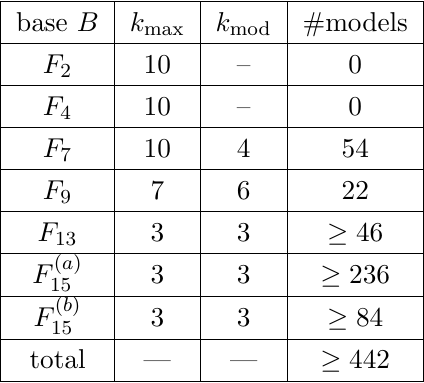
Table 3 . The number of phenomenologically interesting models found for each of the six base manifolds. The scan was carried out over all line bundle models with j k I a j (cid:20) k max and k mod gives the largest value of j k I a j which arises in a physically interesting